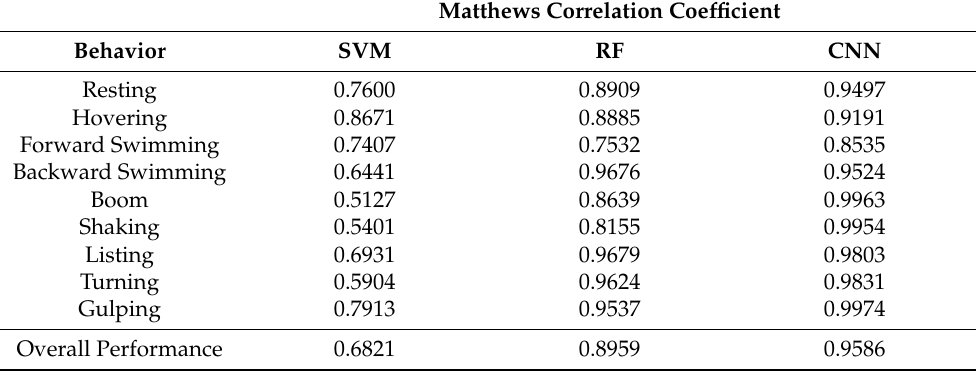
Table 8. Matthews Correlation Coefficient results for the conventional machine learning approaches: support vector machine (SVM) and random forest (RF), and the deep learning approach: convolu- tional neural network